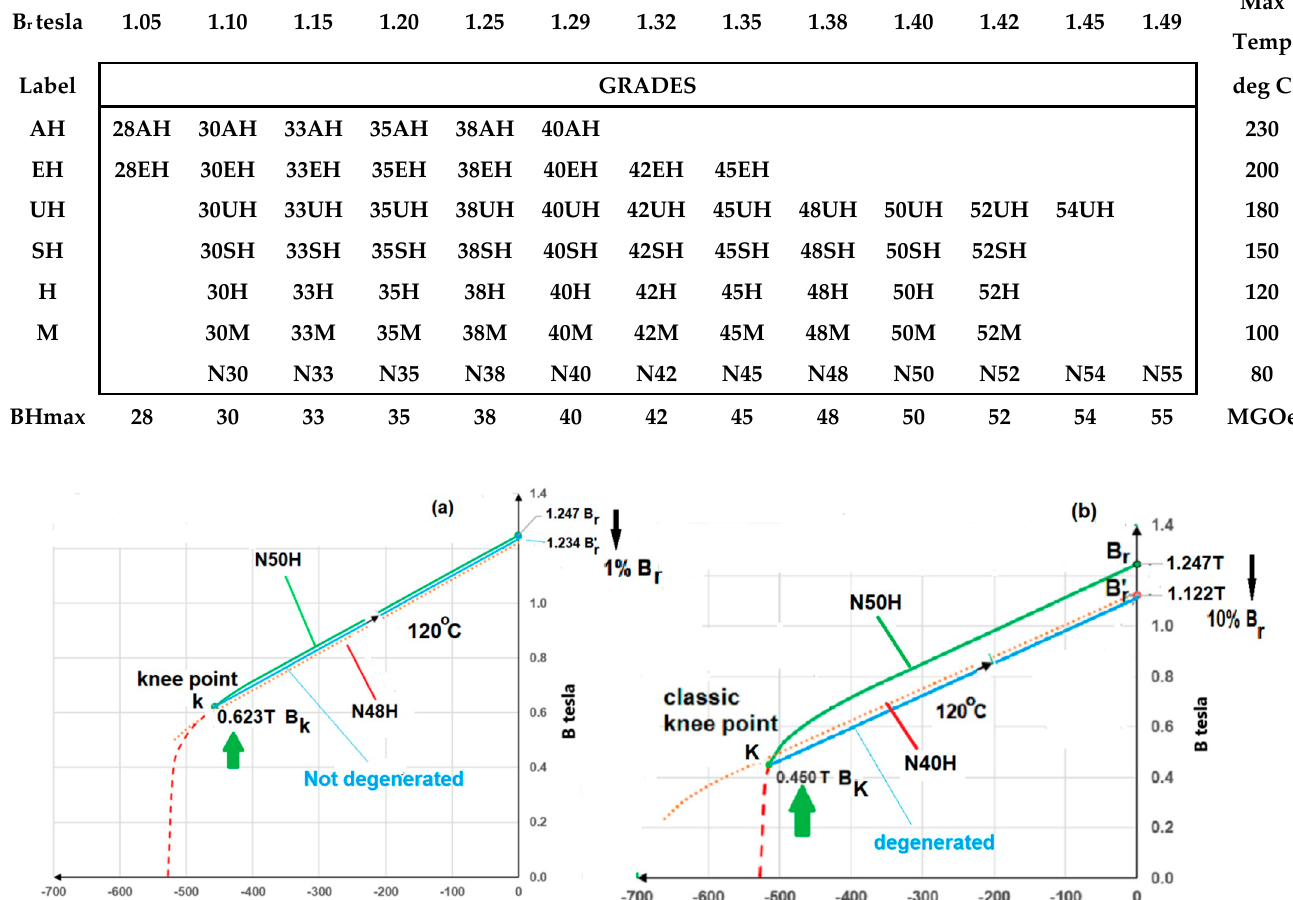
Table 1. Conventional grades of neodymium magnets and their residual flux densities B r .